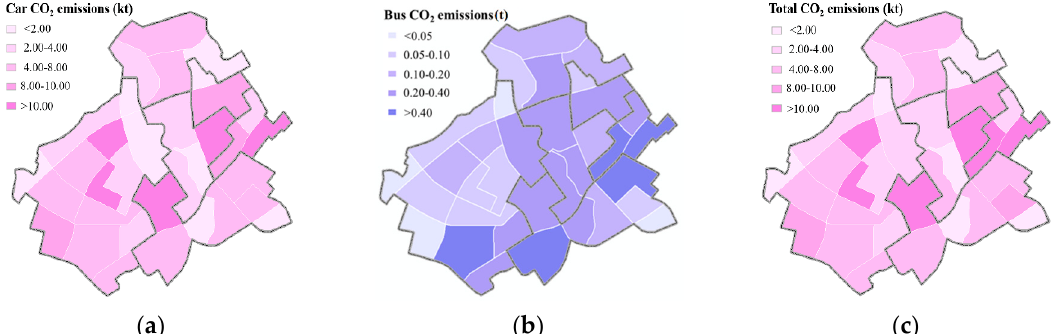
Figure 6. Spatial distribution of the passenger transport emissions of each TAZ. ( a ) Car CO 2 emissions; ( b ) bus CO 2 emissions; ( c ) total CO 2 emissions.